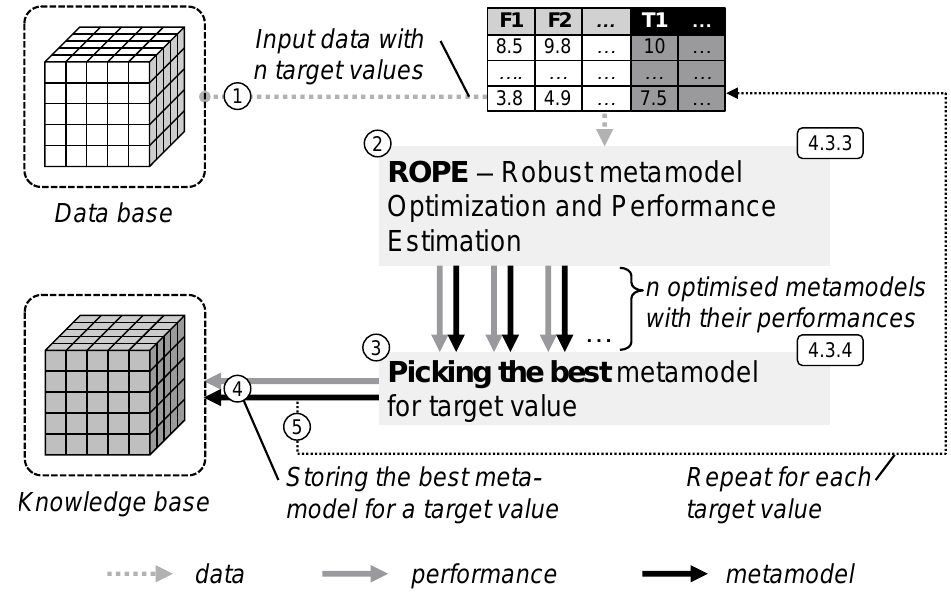
Figure 5. The overall self-learning